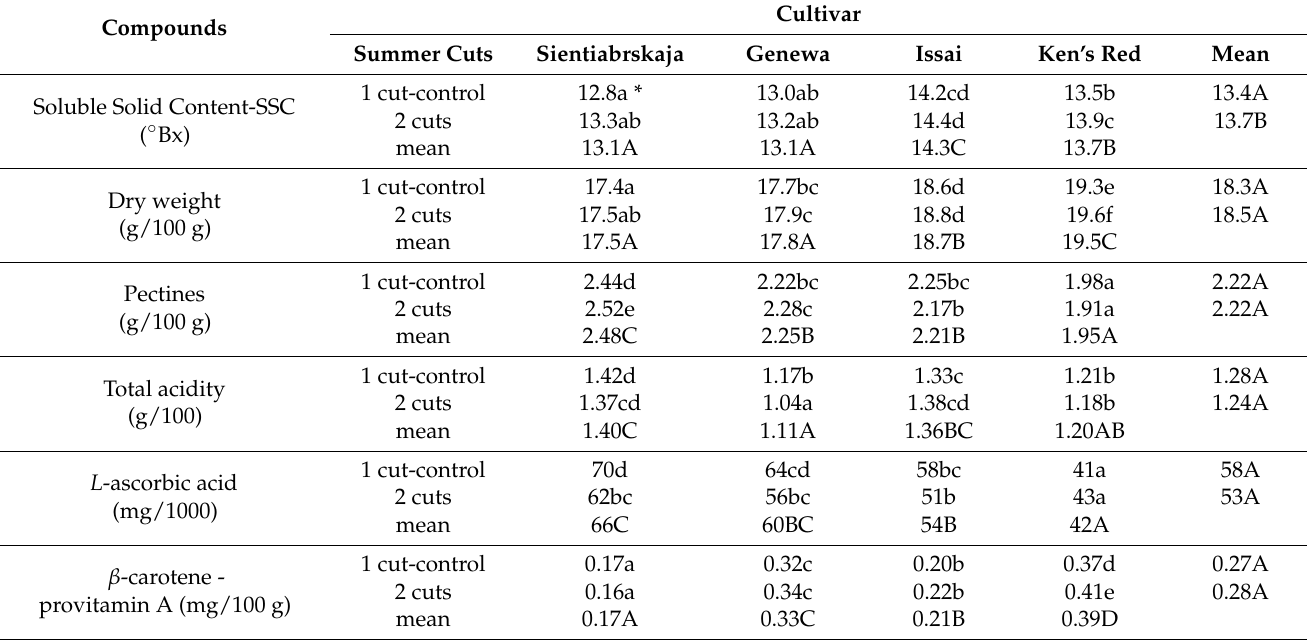
Table 5. The quality, antioxidant capacity of Actinidia